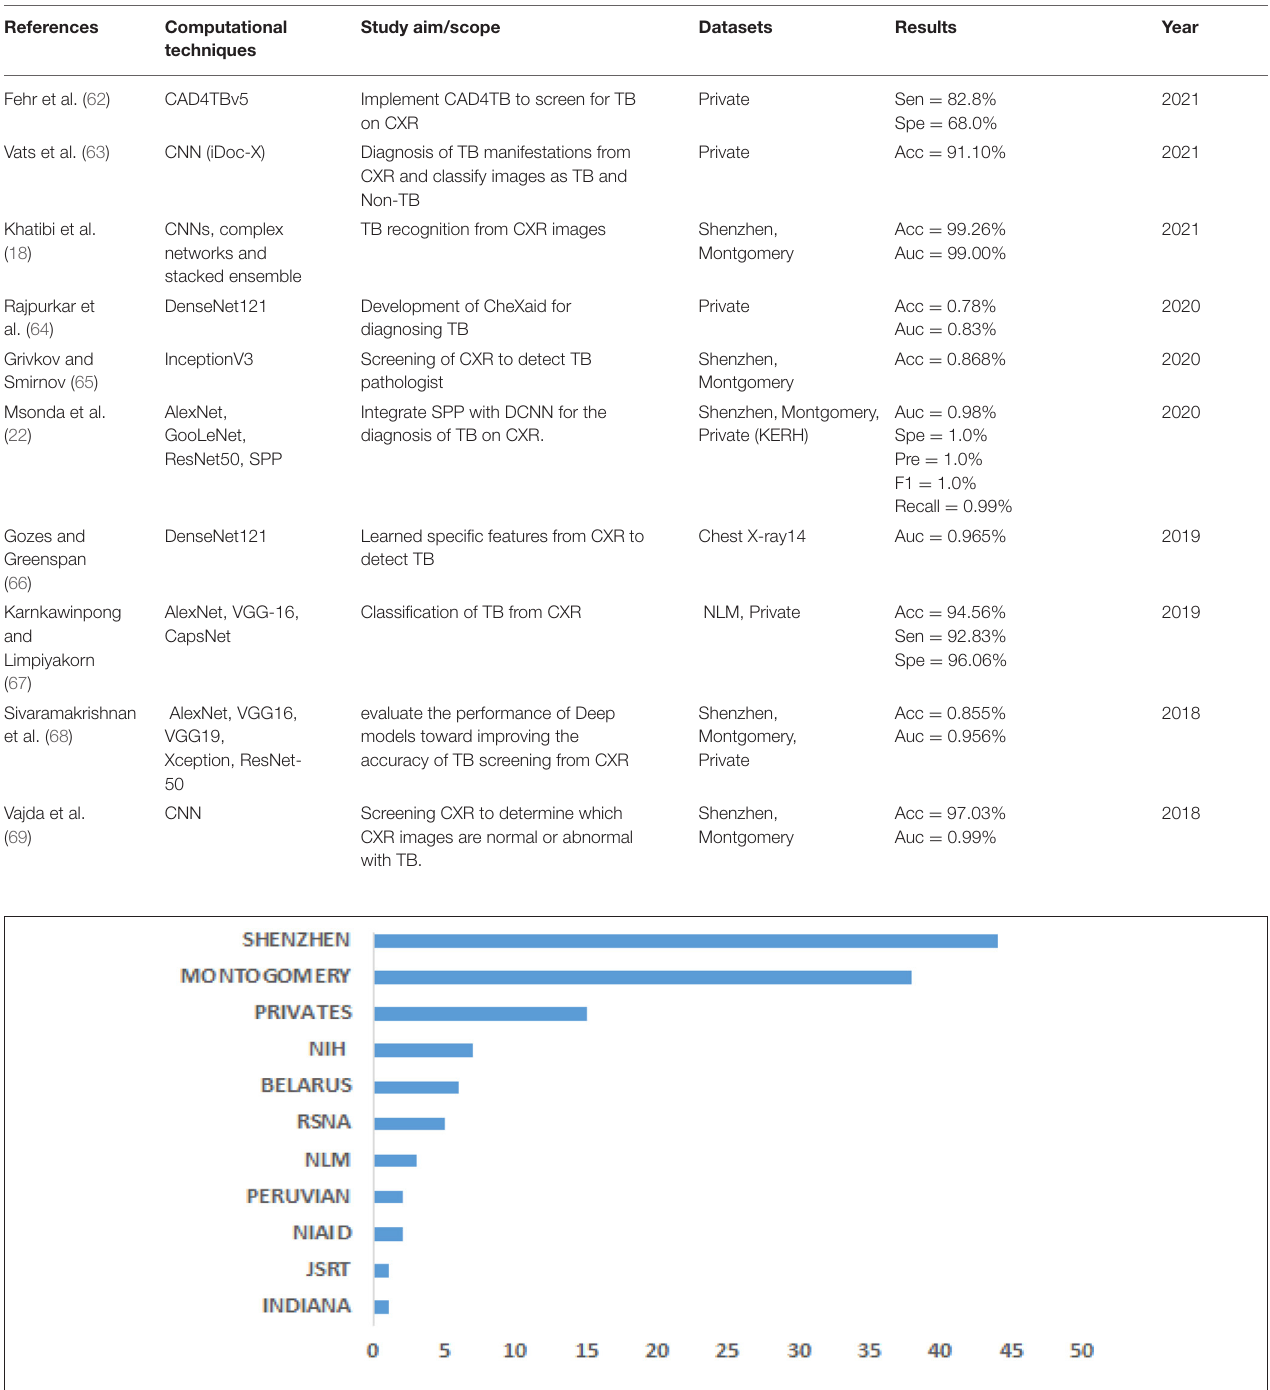
TABLE 5 | Web of Science search results.